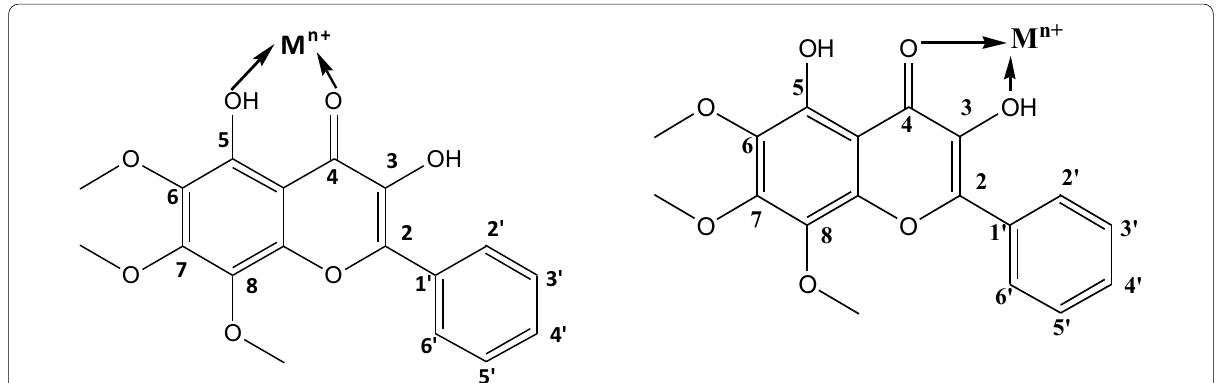
Fig. 1 Possible chelating coordination sites ((3–4) and (4–5)) for the isolated flavone (3,5-dihydroxy-6,7,8-trimethoxyflavone). M n + denotes metal ions, which can be either Ag + or Zn 2